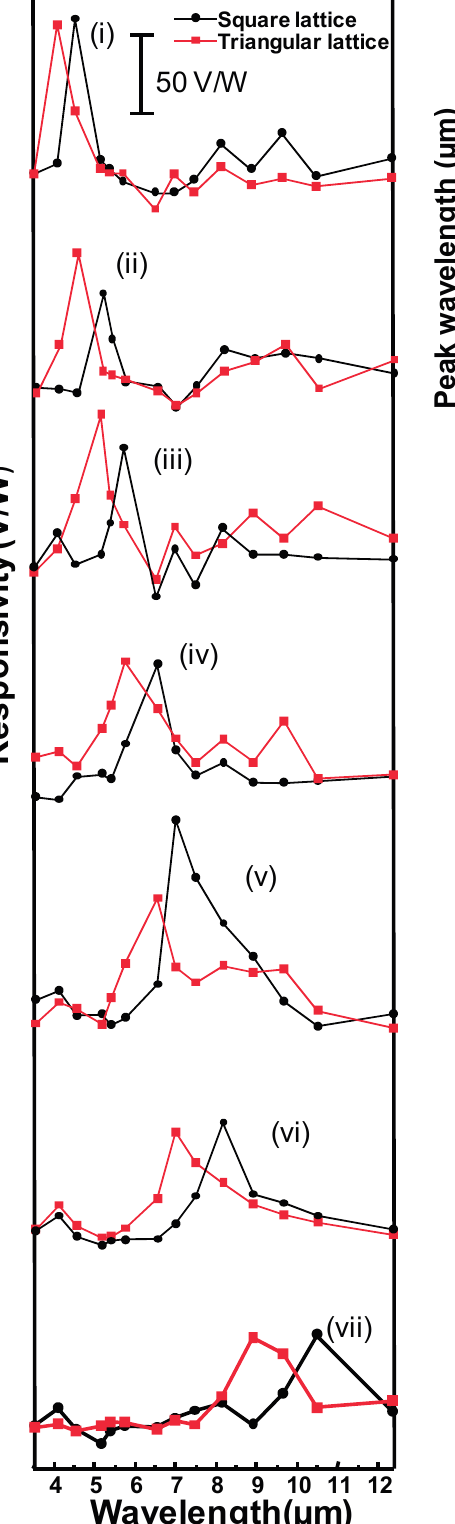
Figure 5. ( a ) Measured spectral responsivity, and ( b ) measured and calculated relation between the surface period and the detection wavelength for triangular and square lattice 2-D